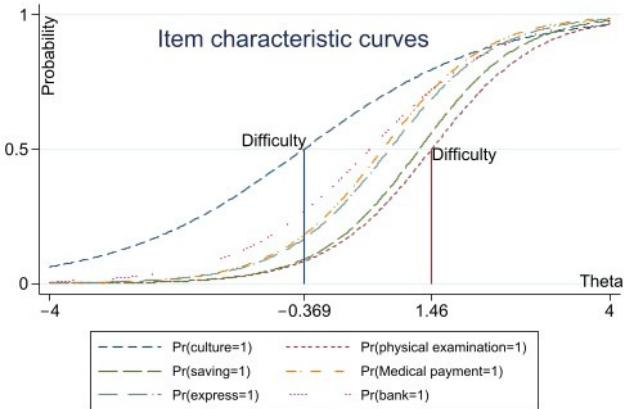
Figure 1. ICC of ‘moderately difficult’ items.